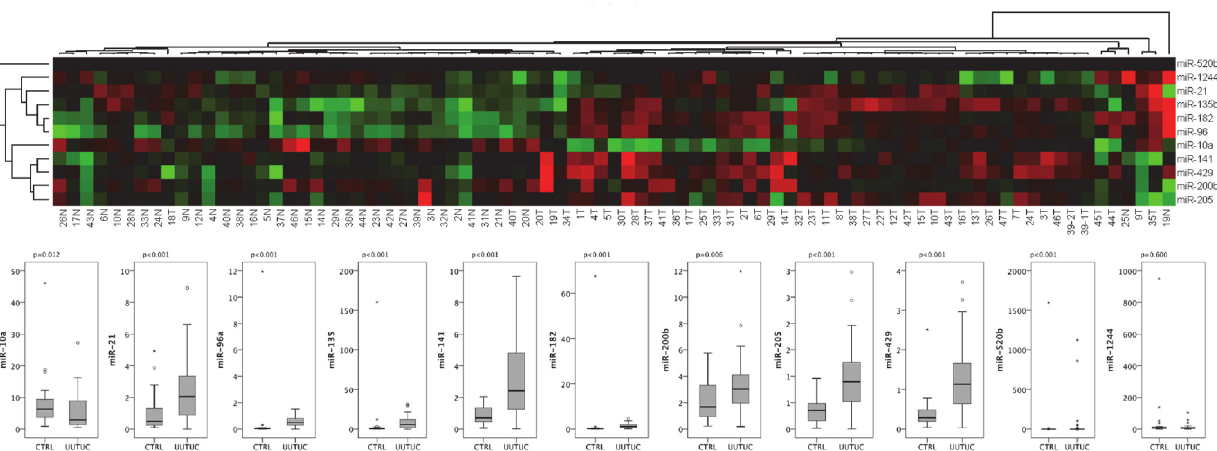
Fig 1. Unsupervised two-way hierarchical cluster analysis with Euclidian distance was performed to classify normal and cancerous urothelial tissue samples. The log2-fold-change was used to construct the heatmap which indicates that a microRNA expression profiling allows differentiation of normal ureter and urothelial carcinoma tissue. The samples from normal urothelial tissue are coded with “ N ” , the cancer samples with “ T ” . The Boxplot diagrams indicate relative levels of each target microRNA.